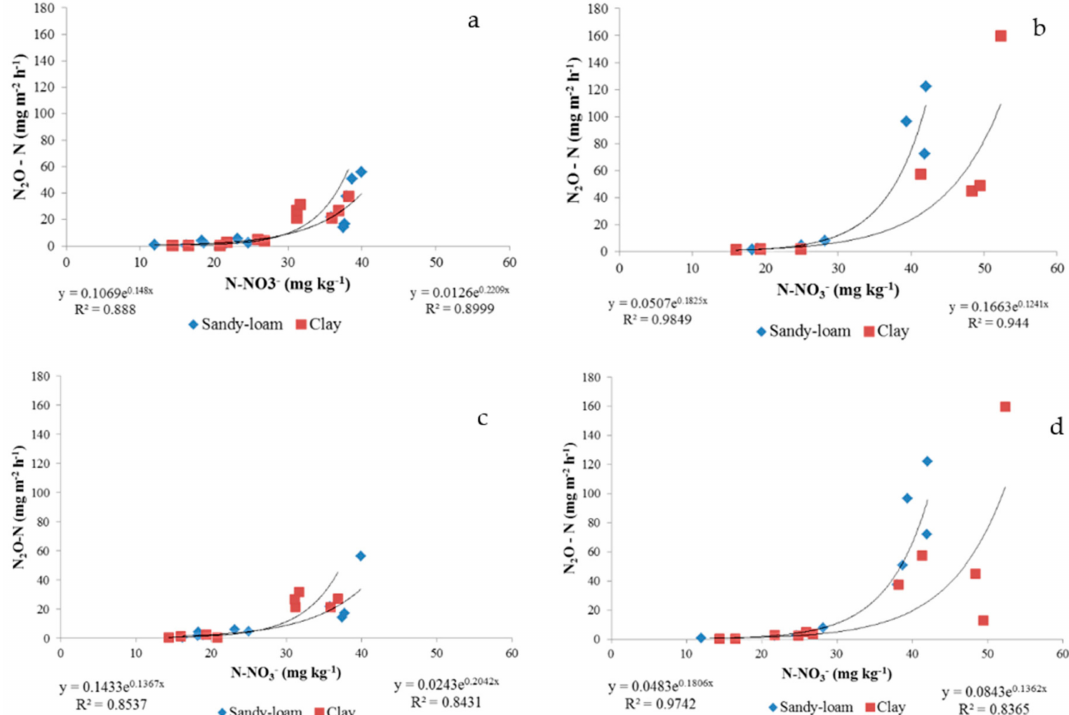
Figure 4. ( a ) N 2 O fluxes vs. soil nitrate concentration in the 10–39% WFPS range and ( b ) 40–60% WFPS range; ( c ) N 2 O fluxes vs. soil nitrate concentration in the 25–28 ◦ C Tsoil range and in the ( d ) 29–32 ◦ C Tsoil